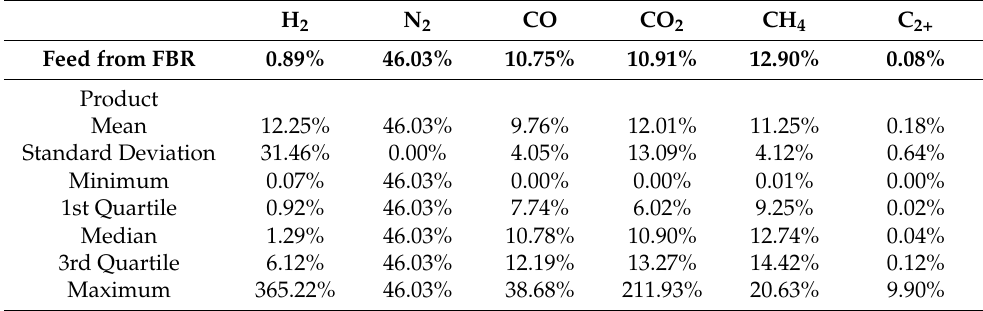
Table A2. Product gas composition from the ZVI Reactor. Product gas compositions are normalised to the feed gas composition. FBR = Halite Reactor. The table demonstrates CO + CH 4 adsorption and H 2 + CO 2 + C 2+